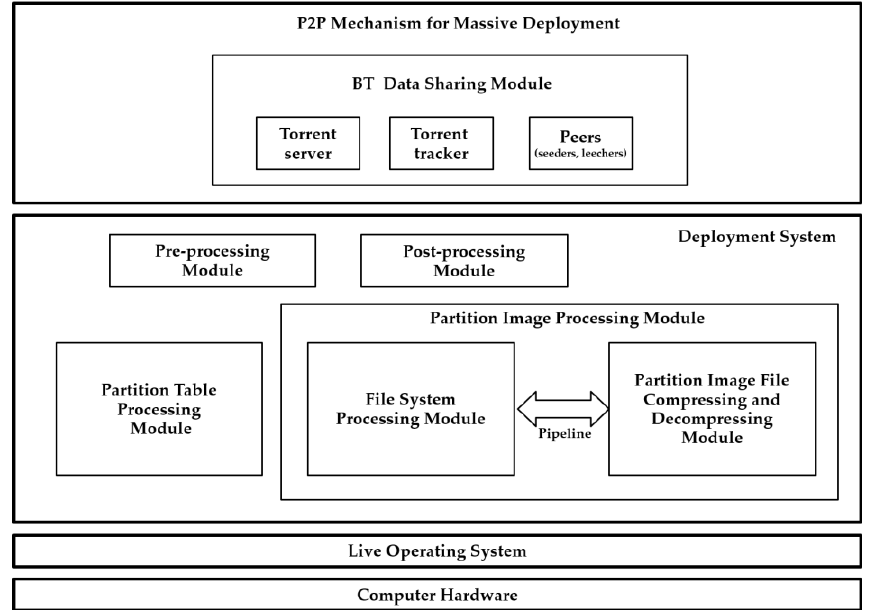
Figure 3. The proposed system architecture for P2P massive system deployment.